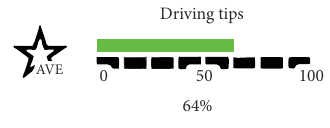
Figure 4. Average